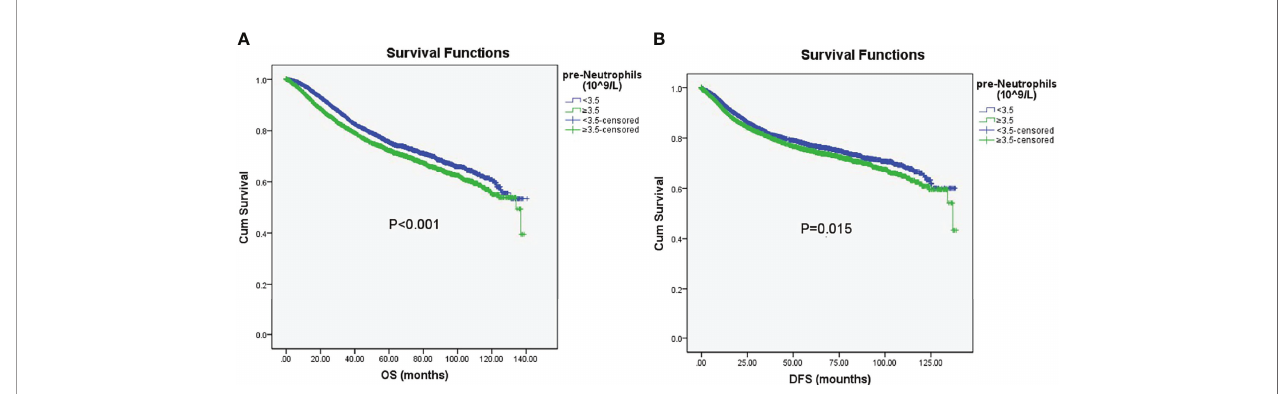
FIGURE 7 | Kaplan – Meier analysis of OS and DFS. (A) Kaplan – Meier survival curve for OS according to preoperative neutrophils (pre-neutrophils) in the propensity score-matched cohort (OS, Logrank=13.743, P < 0.001). (B) Kaplan – Meier survival curve for DFS according to preoperative neutrophils (pre-neutrophils) in the propensity score-matched cohort (DFS, Logrank= 5.910, P = 0.015). Statistical signi fi cance was set at P